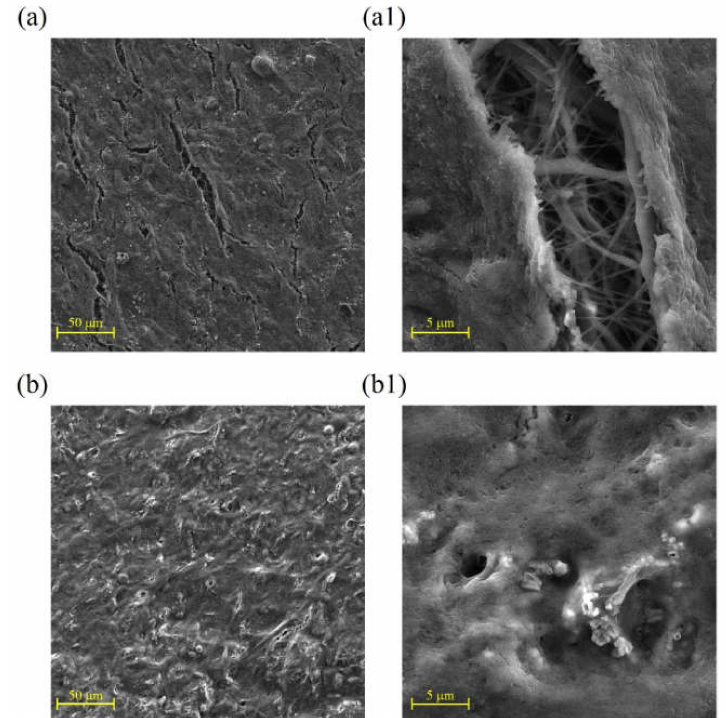
Figure 8. SEM images showing 3T3 fibroblast cell line adhesion on ( a , a1 ) the pristine PCL electrospun samples; ( b , b1 ) collagen / chitosan grafted specimens (cultured for 3 days).